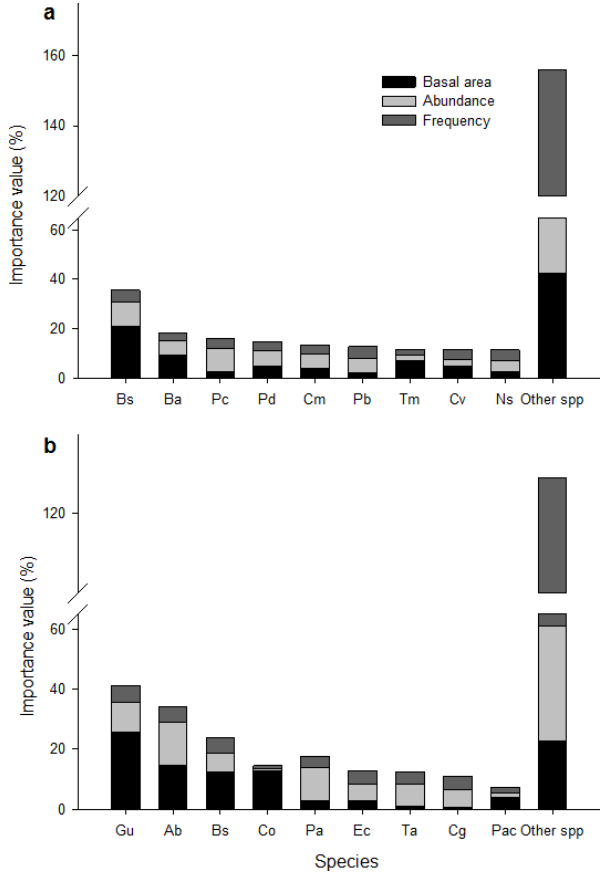
and Tm: Talasia macrophylla .